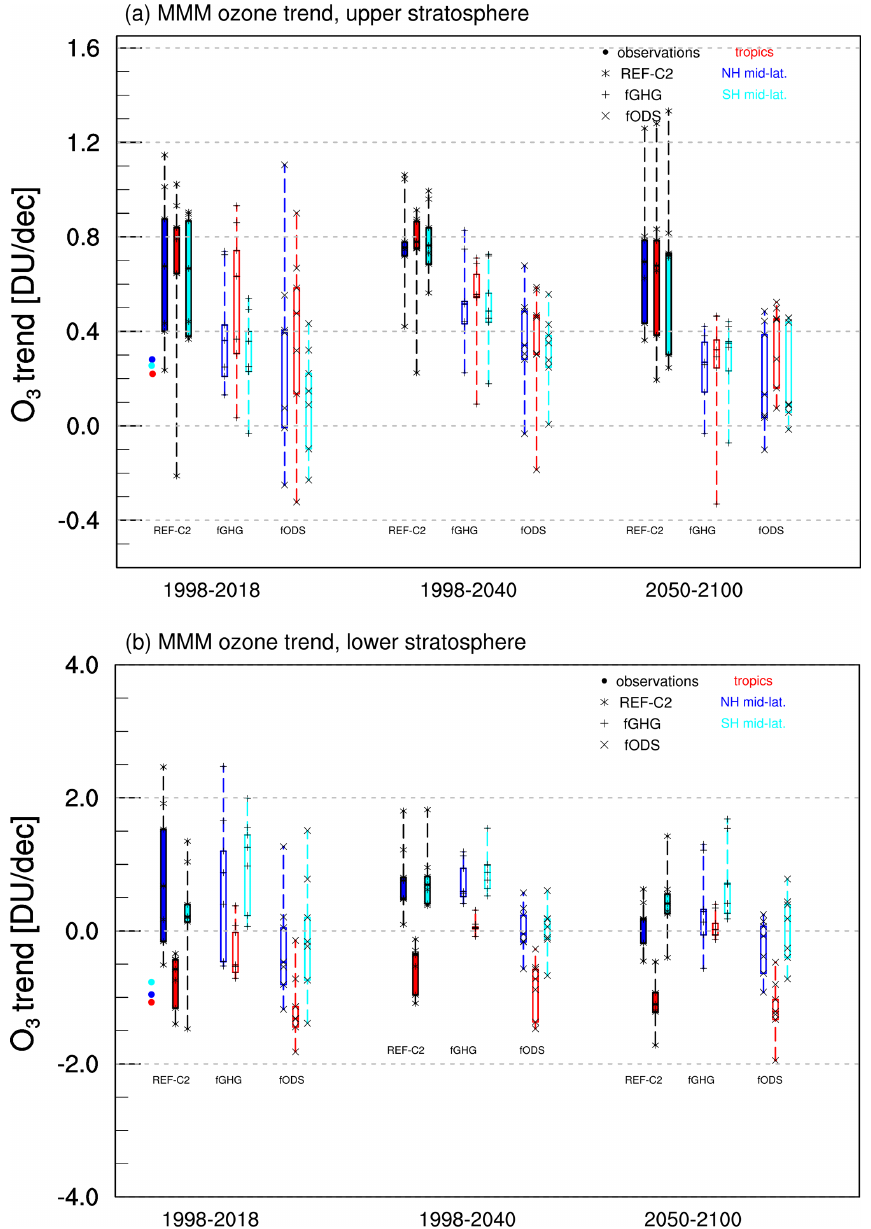
Figure 8. MMM ozone column trends in the tropics (red; 20 ◦ N–20 ◦ S), in the northern mid-latitudes (blue; 30–50 ◦ N), and in the southern mid-latitudes (cyan; 30–50 ◦ S) for thee different periods (i.e. 1998–2018, 1998–2040, 2050–2100) for (a) the upper stratosphere (1–10hPa) and (b) the LS (30–100hPa in the tropics, 150hPa in the mid-latitudes). The boxes extend from the lower to upper quartile of the data, with a line for the median and with whiskers to show the minimum and maximum values of the LS MMM ozone trends. MMM trends are given for REF-C2 simulations (filled boxes) as well as for fGHG and fODS simulations (not-filled boxes). Note here that for the estimate of MMM trends only 10 model simulations are taken into account as this is the maximum of available fGHG simulations, and we want to ensure that all three simulation types include the same models for the MMM trend estimate. Individual model trends are denoted by black stars for REF-C2, by black pluses for fGHG, and by black crosses for fODS. Observational data are included for the trends over the period 1998–2018 (red, blue, and cyan points,